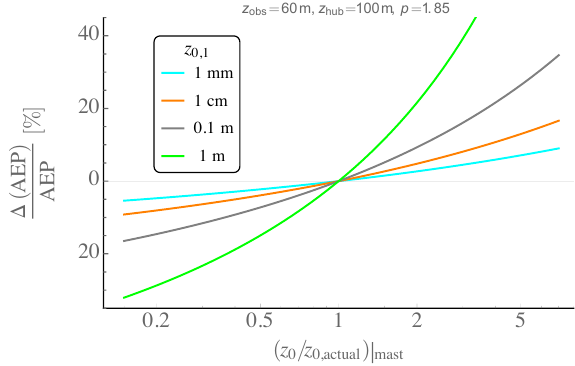
Figure 7. Sensitivity of (error in) predicted normalized power due solely to error in background roughness at measurement site vs. ra- tio of estimated to actual background z 0 at observation mast (i.e., 1 + relative error, Eq. 9) for various values of actual z 0 , 1 . Observa- tion height is 60m and hub height is 100m, as in Figs.